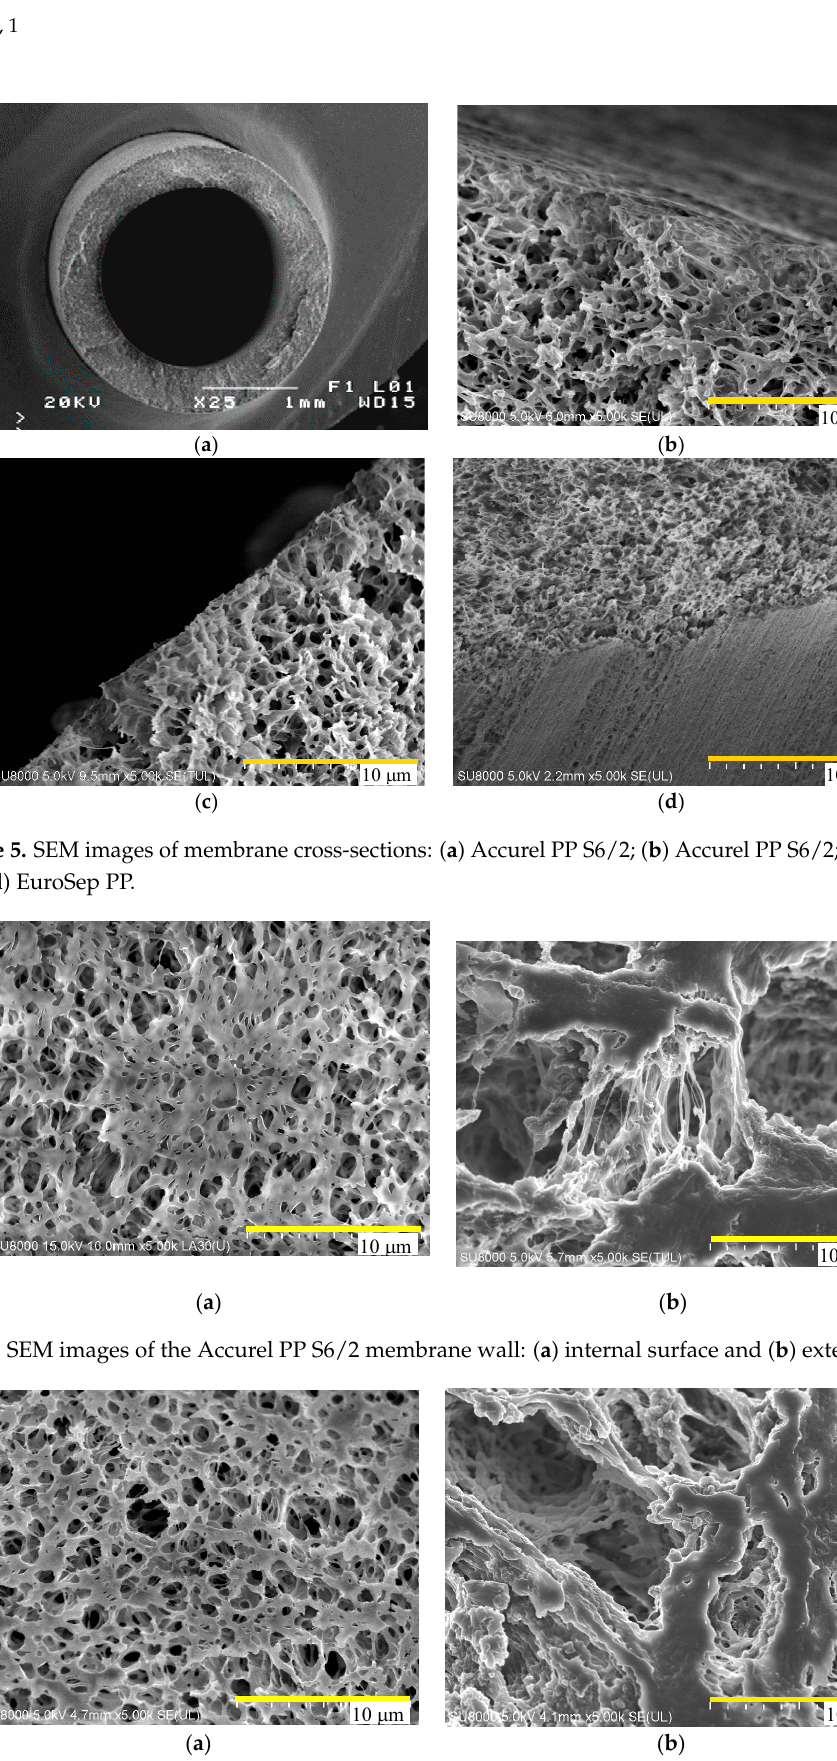
Figure 7. SEM images of the K1800 membrane wall: ( a ) internal surface and ( b ) external surface.